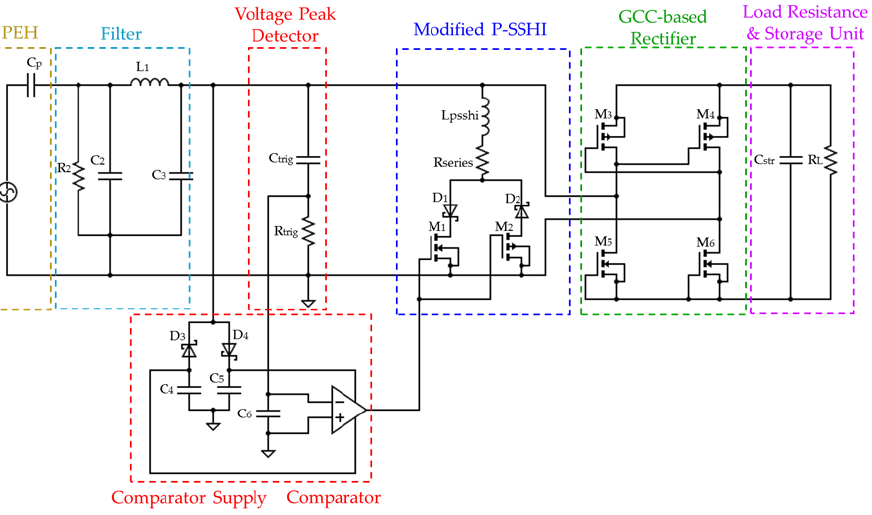
Figure 5. Proposed SP-PSSHI energy harvesting circuit